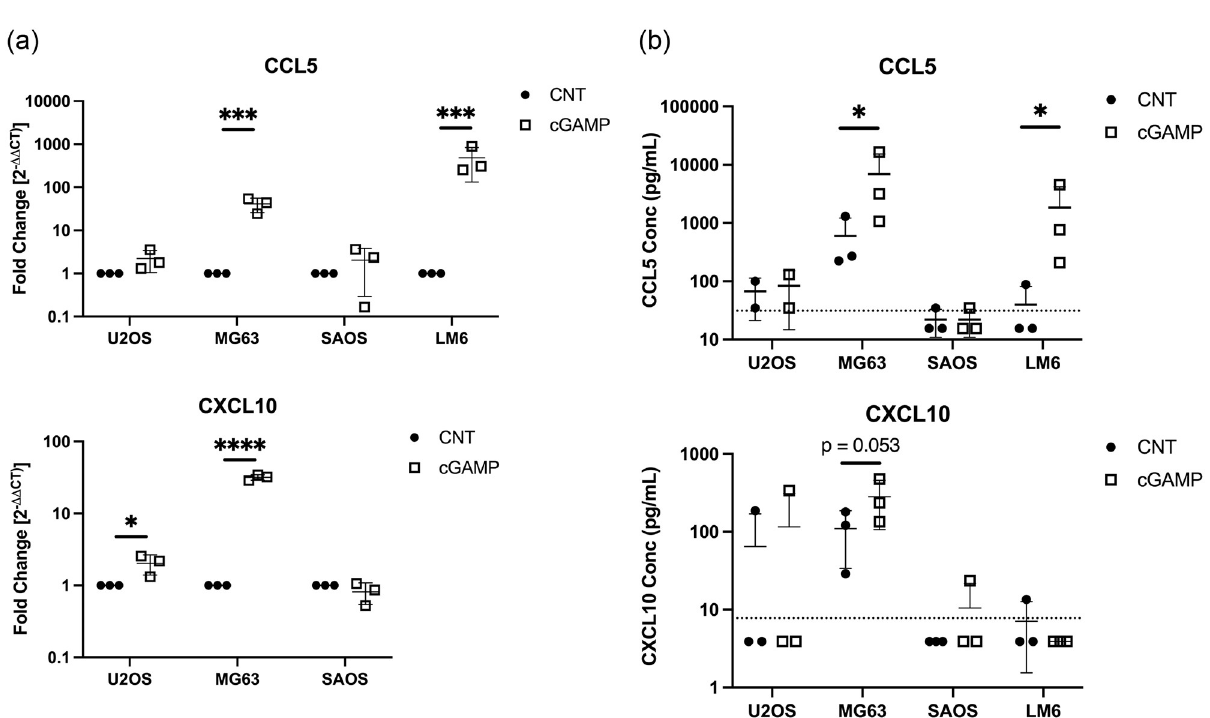
Fig 2. Expression of chemokines induced by STING agonism in hOSA cells. A) CCL5 and CXCL10 mRNA expression depicted as fold change (2 - ΔΔ Ct ) in cells treated with 2’3’-cGAMP (10 μ g/mL for 16 hrs) relative to control cells. RT-qPCR was performed in duplicate. N = 3. B) CCL5 and CXCL10 protein expression in cGAMP-stimulated cell lines (10 μ g/mL for 24 hrs) relative to control cells was determined by ELISA. The dashed horizontal line represents the lower limit of detection for the CCL5 (31.2 pg/mL) and CXCL10 (7.8 pg/mL) ELISAs used. ELISAs were performed in duplicate. N = 2–3. Individual data points are plotted, mean and SD are shown. The y-axes are represented on a log 10 scale. * p < 0.05; *** p < 0.001; **** p < 0.0001.